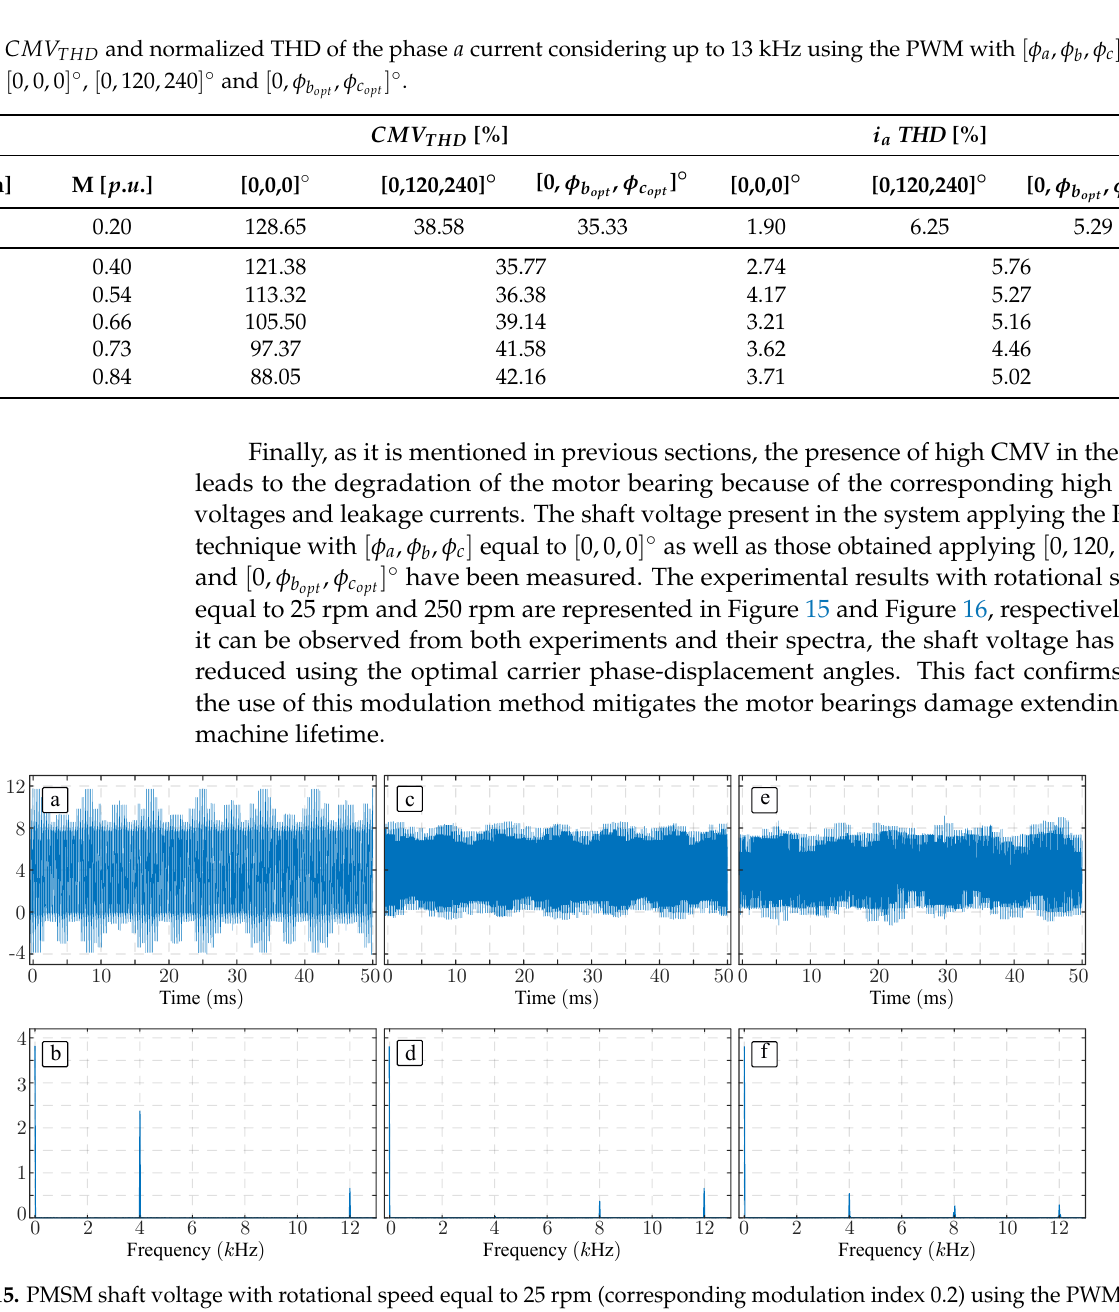
] ◦ . ( b , d , f ) are , φ c opt opt